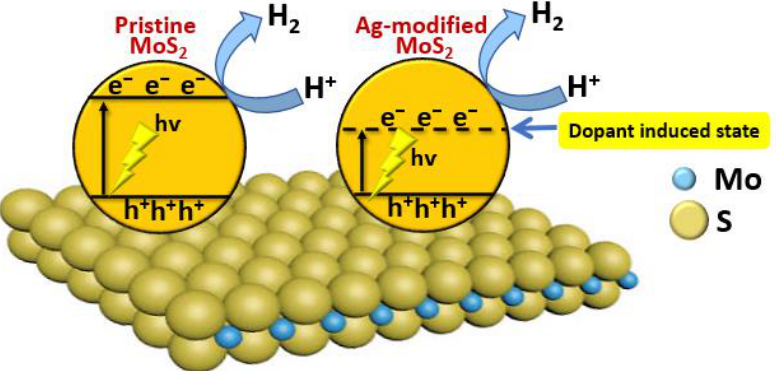
Figure 8. The mechanism of photocatalytic H 2 production using Ag-modified MoS 2 nanosheets. Photocorrosion-resistant material, MoS 2 /Zn 0.5 Cd 0.5 S/g-C 3 N 4 , has been